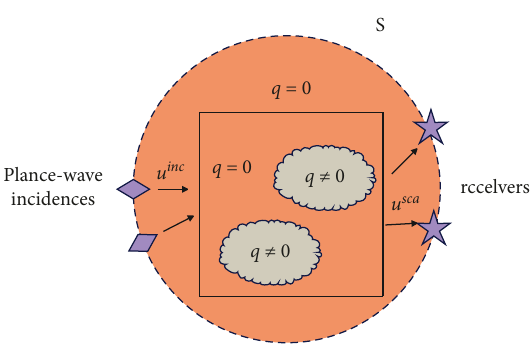
Figure 1: Geometric model of the scattering